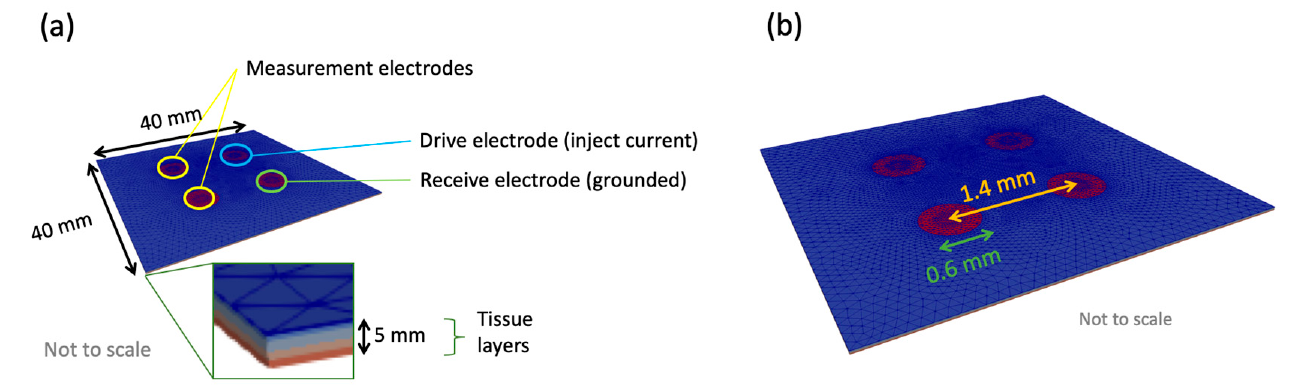
Figure 6. ( a ) A tissue scale model with dimensions and electrodes indicated. Potential difference was calculated between the two measurement electrodes (defined as coupled sets in Ansys). ( b ) Electrode dimensions for the tissue scale model.